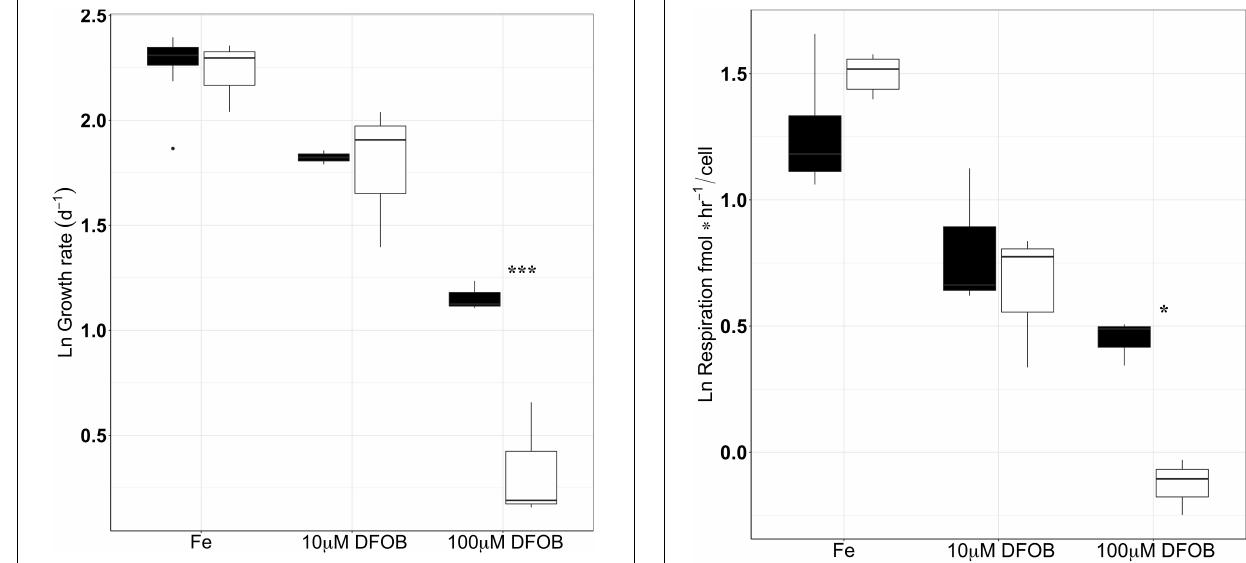
FIGURE 6 | Respiration rates of wt (black) and (cid:49) icl (white) under different levels of Fe-limitation (Fe-replete, 10 µ M DFOB and 100 µ M DFOB) performed in triplicate. The natural logarithm (ln) was used in order to account for a skewed data set. Significant differences between wt and (cid:49) icl are marked with an asterisk, where ∗ p < 0.05, ∗∗ p < 0.005, ∗∗∗ p < 0.0005.